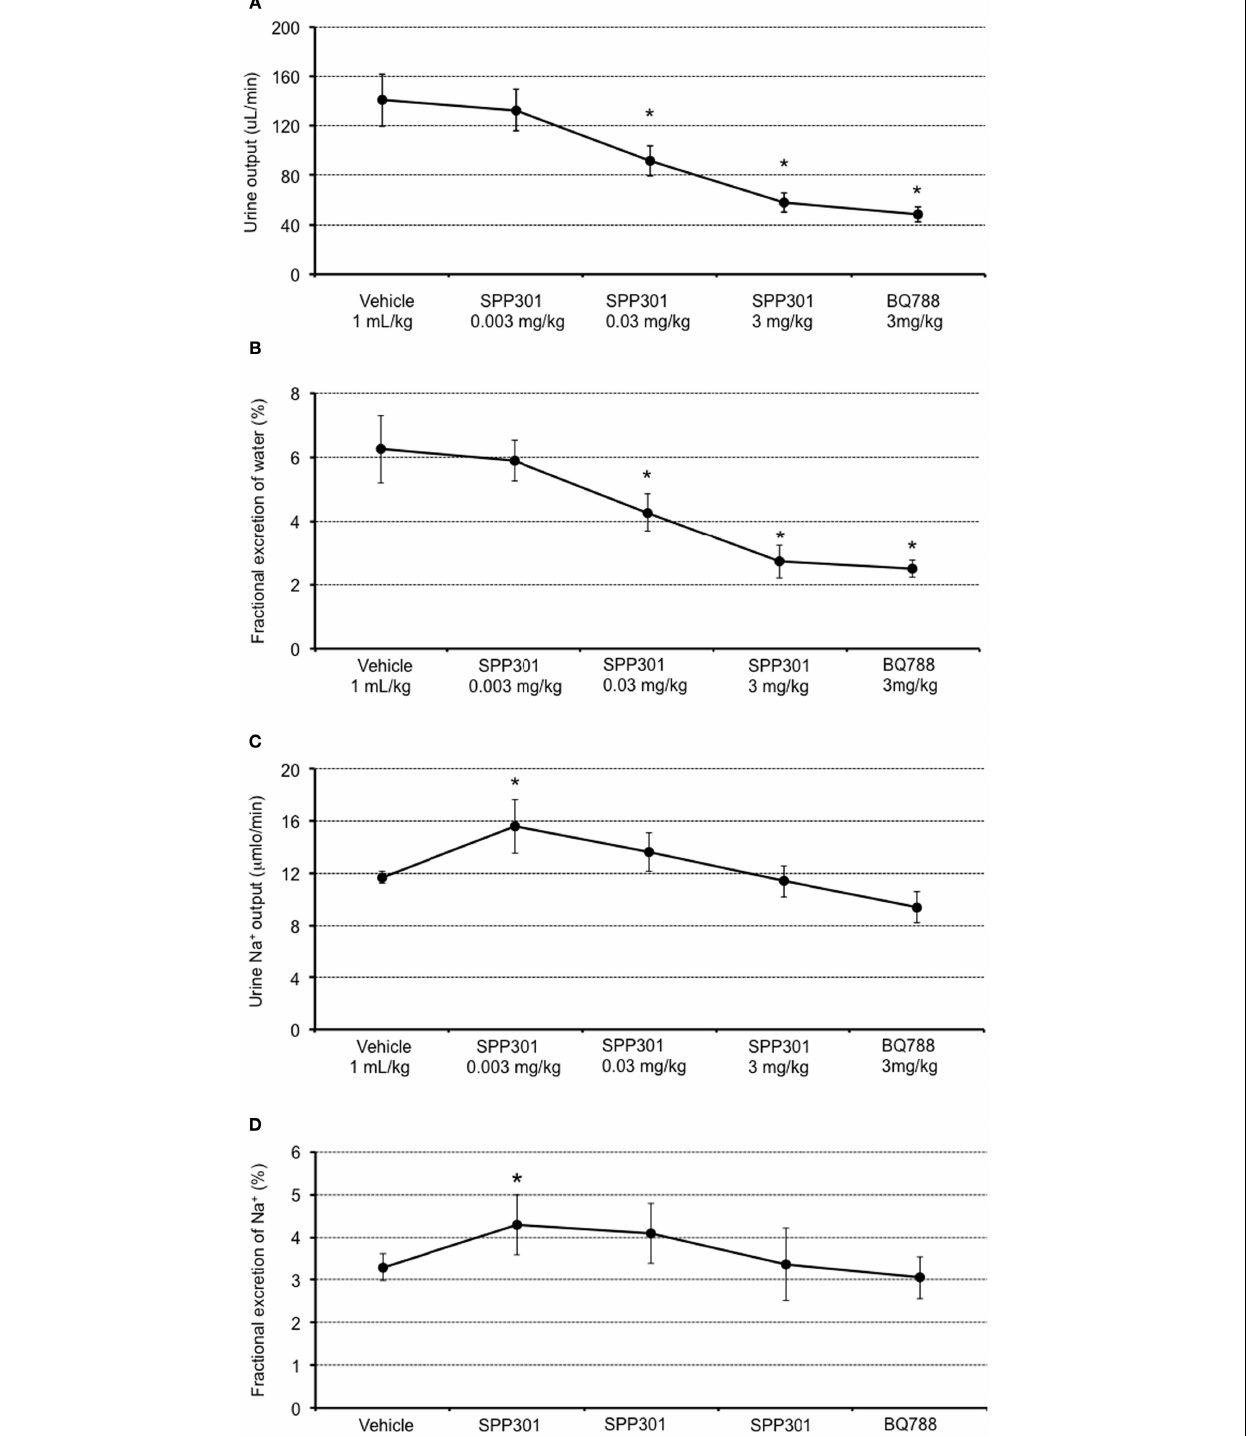
excretion of water (percentage of water excreted by the kidney from the total amount filtered) = urine output/GFR. Fractional excretion of sodium (percentage of Na + excreted by the kidney from the total amount filtered) = urine Na + output/[Plasma (Na + ) × GFR]. * p < 0.05 compared with control